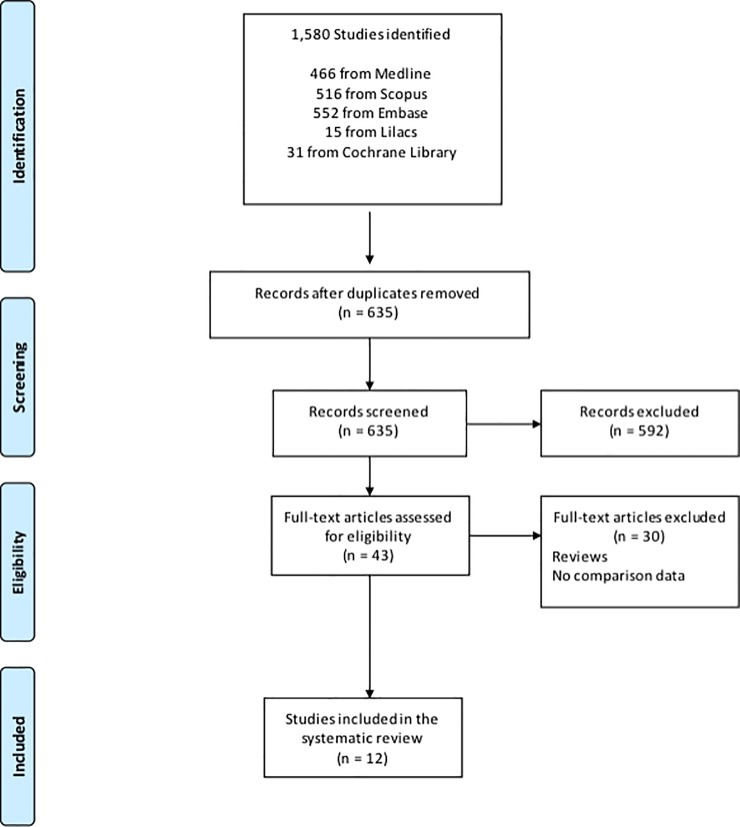
PRISMA flowchart of the literature search and study selection.